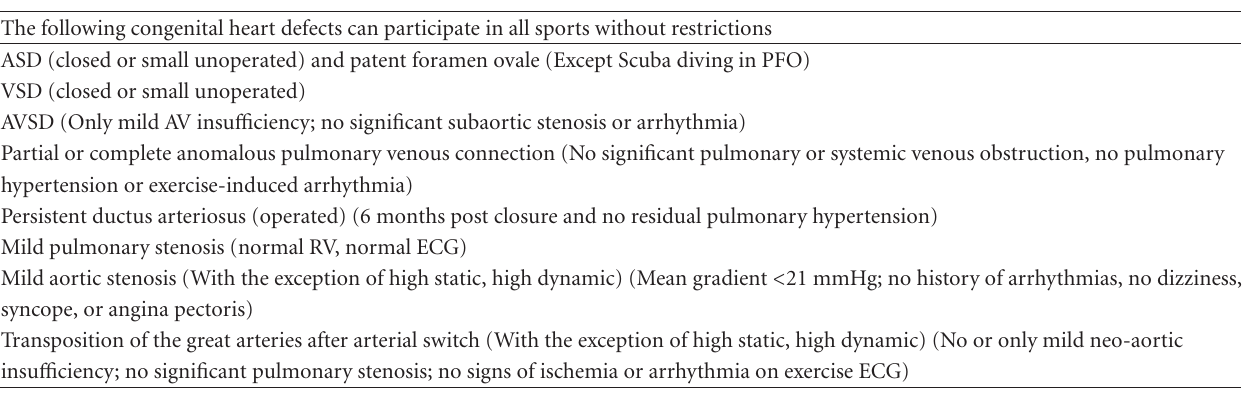
Table 3: Recommendations for competitive sport